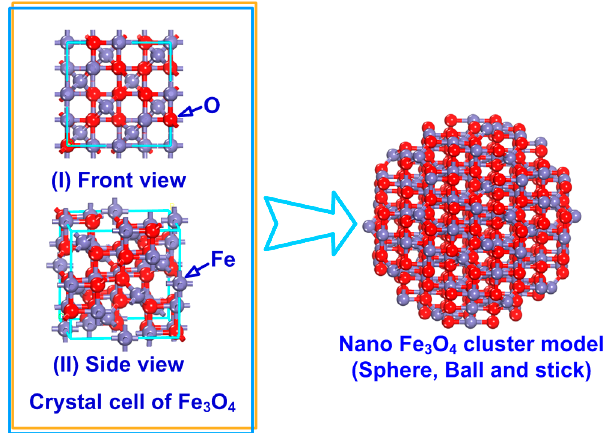
Figure 10. Molecular structure of nano-Fe 3 O 4 .